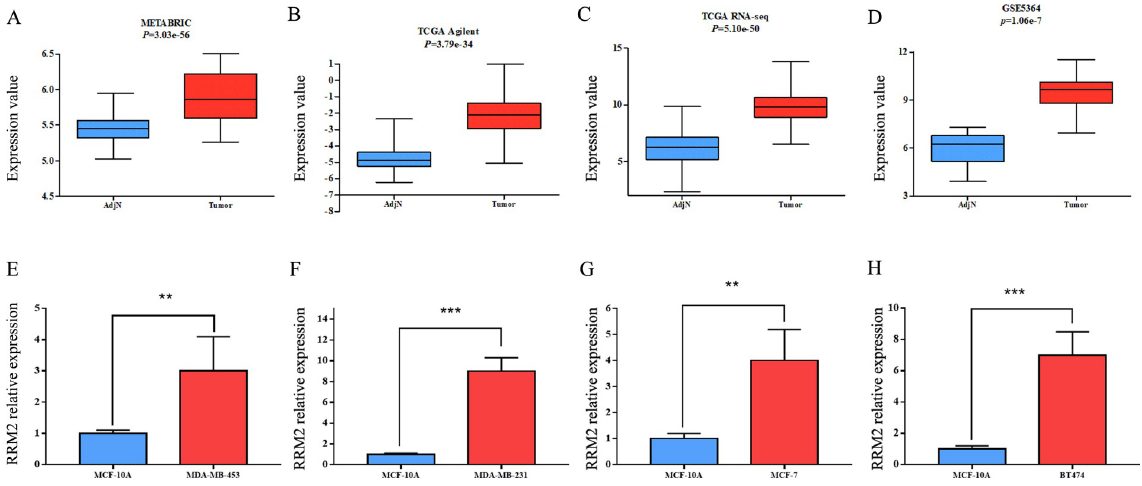
Fig 1. Expression of RRM2 in breast cancer tissues from public databases and breast cancer cell lines by qRT-PCR. (A) METABRIC; (B) TCGA Agilent; (C) TCGA RNA-seq; (D) GSE5364; (E) MDA-MB-453; (F) MDA-MB-231; (G) MCF-7; and (H) BT474.